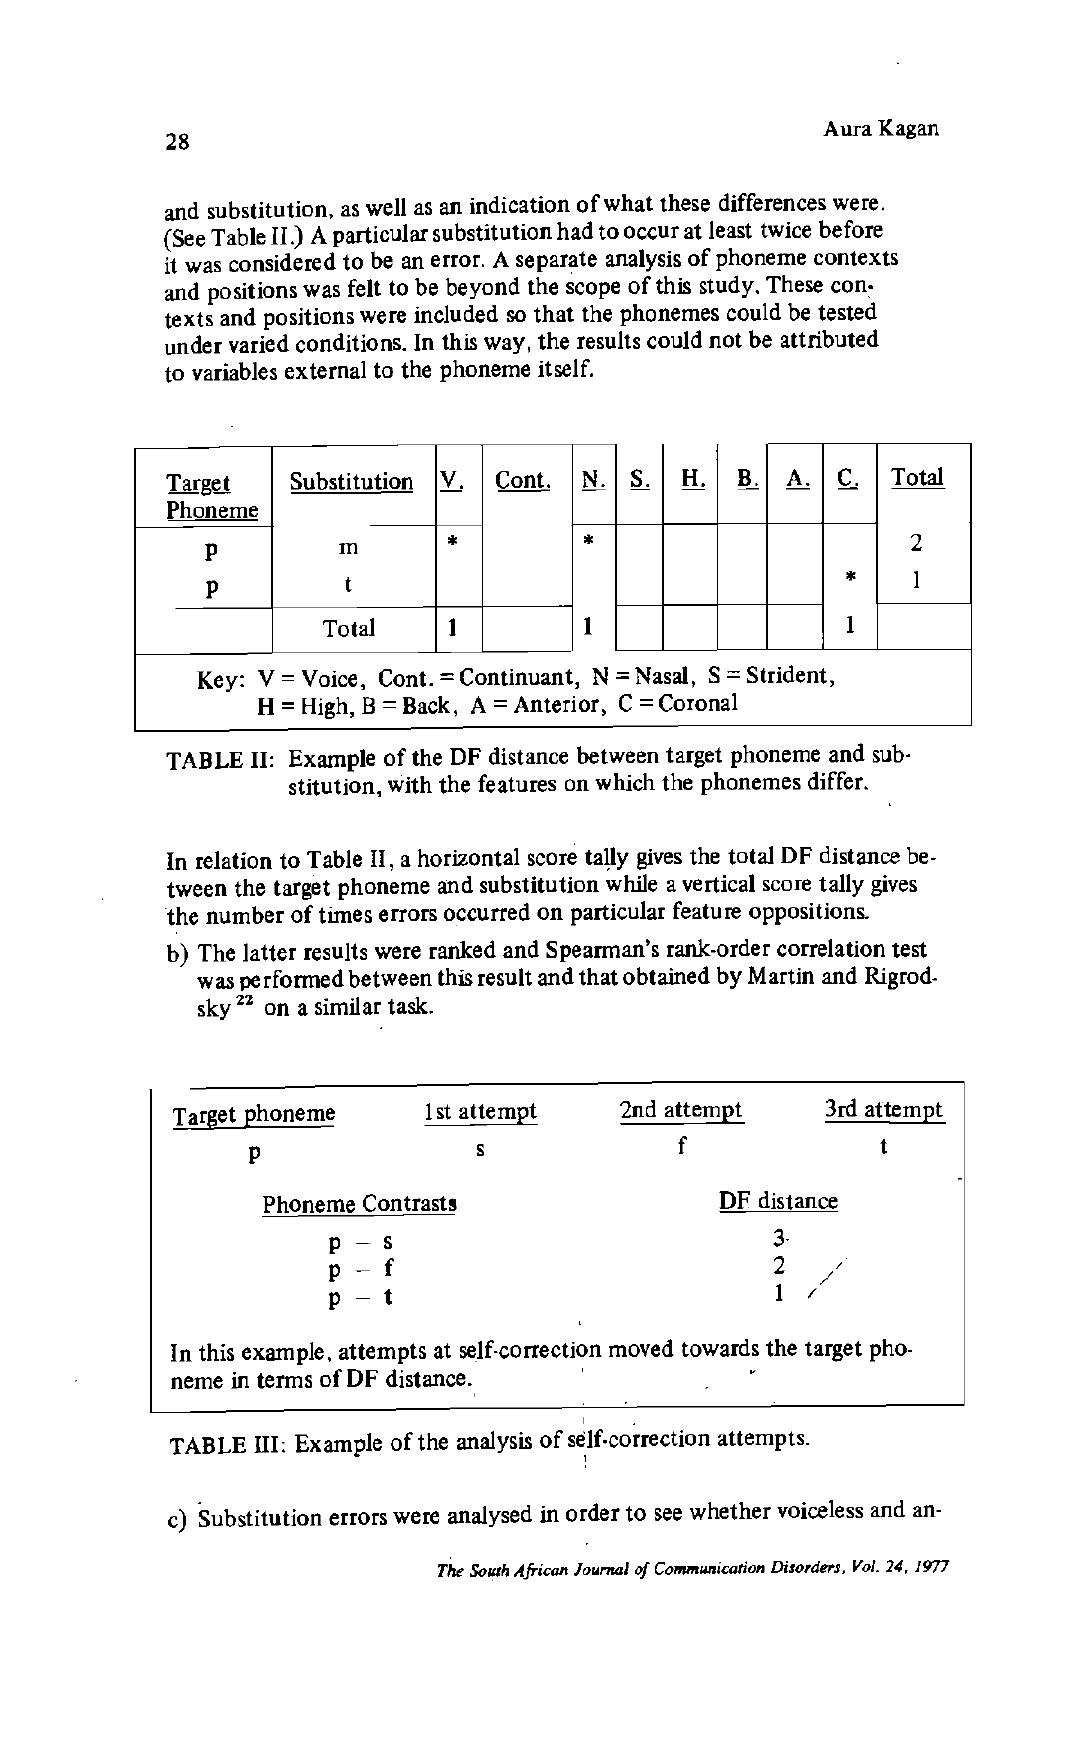
TABLE III: Example of the analysis of self-correction attempts. c) Substitution errors were analysed in order to see whether voiceless and